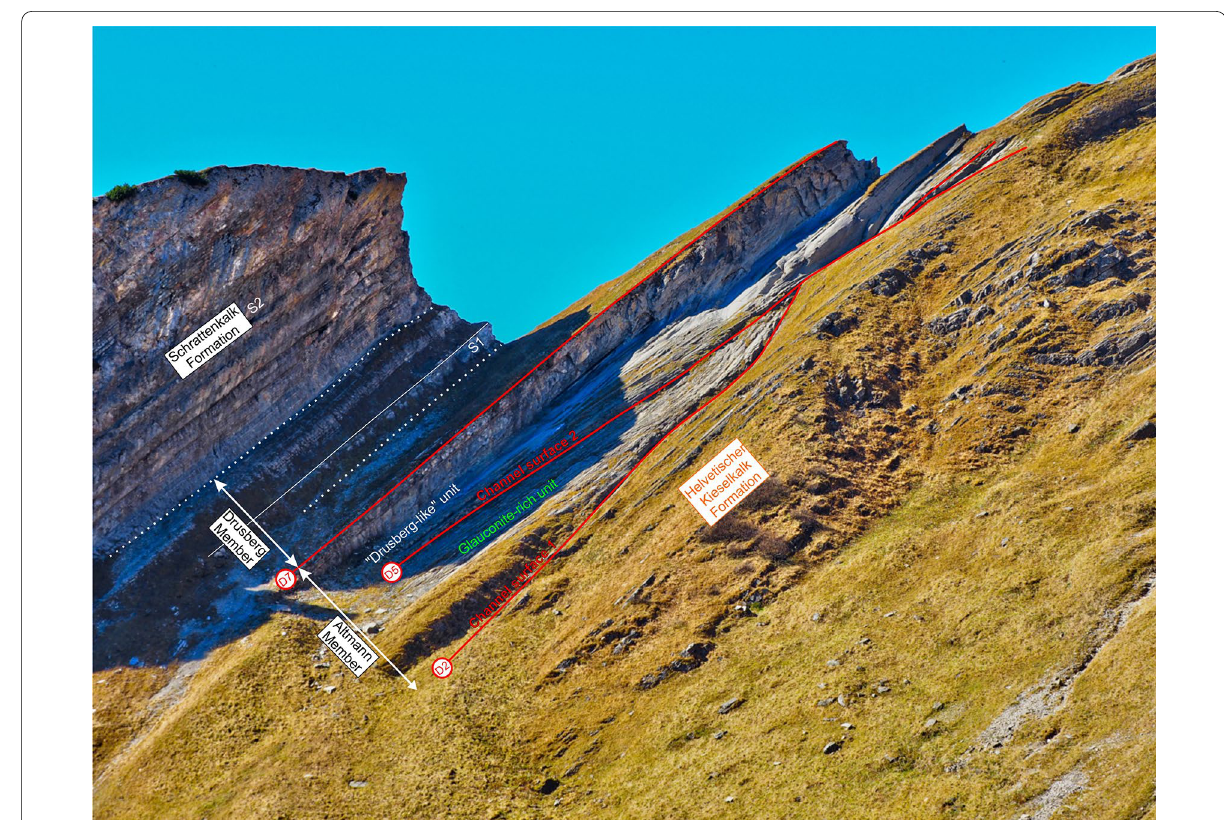
Fig. 10 Litten-Chreialp outcrop presenting a temporal succession of depressions (tectonically induced depressions and/or channels?) filled by the Altmann Member